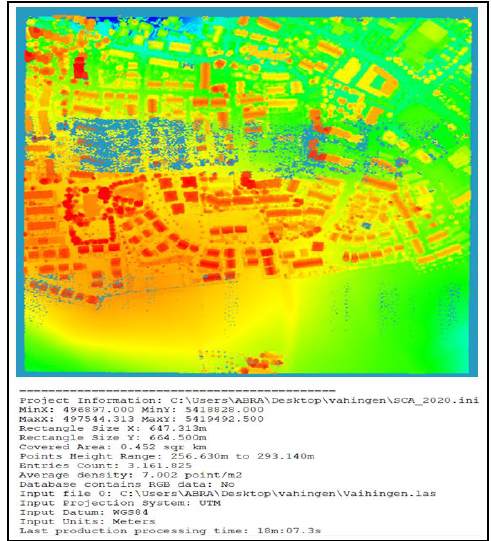
Figure 1. Data specifications and visualization